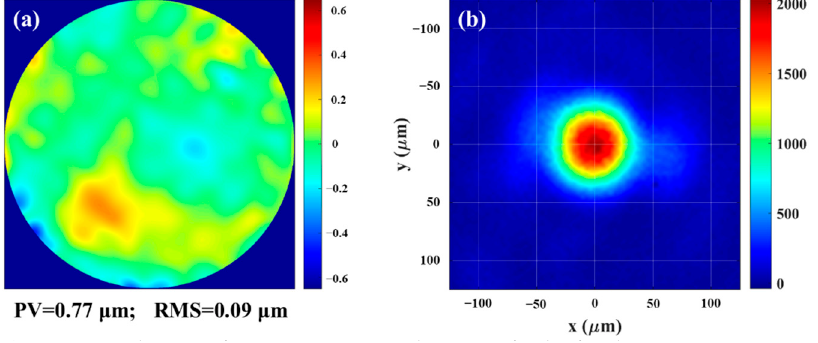
Figure 3. ( a ) The wavefront map measured at WFS ( b ) the focal spot image measured by CCD, after AOS closed-loop operation in air.